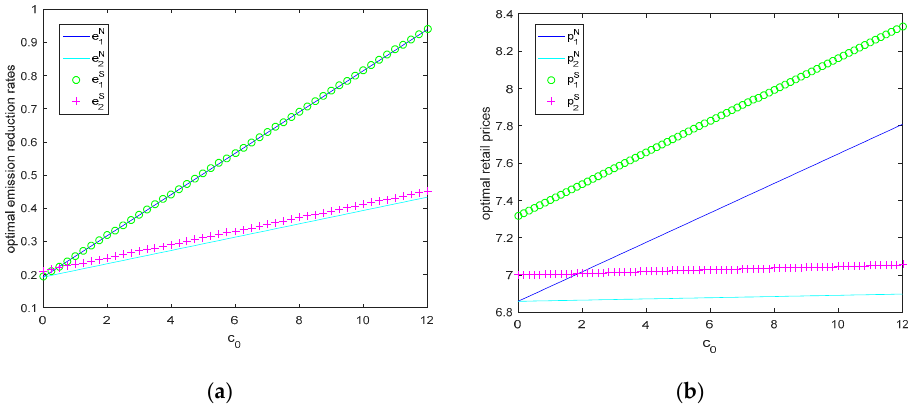
Figure 2. ( a ) Optimal emission reduction rates and ( b ) optimal retail prices as a function of c0 when the total carbon quota is insufficient and sufficient.